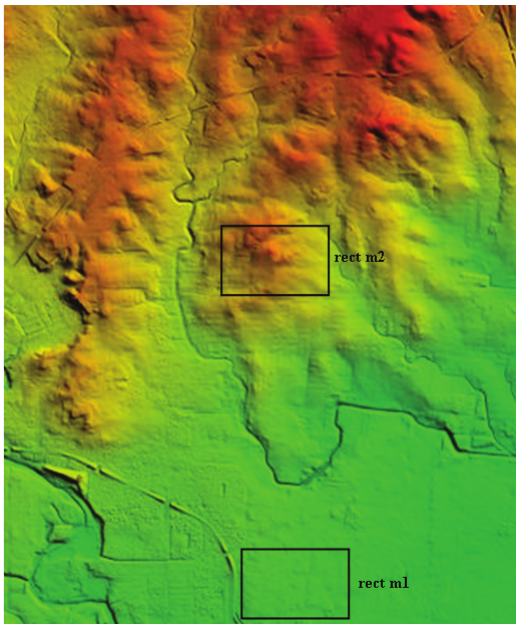
Fig. 1. Satellite Digital image HI-DEM of the